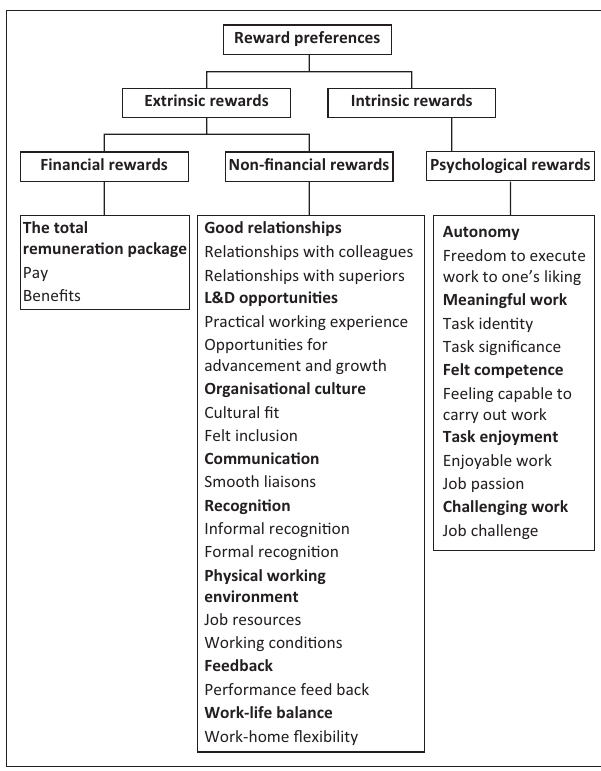
FIGURE 1: A clean editable figure was provided in the word document for processing, please check and provide for neat display and clarity in reading as per style